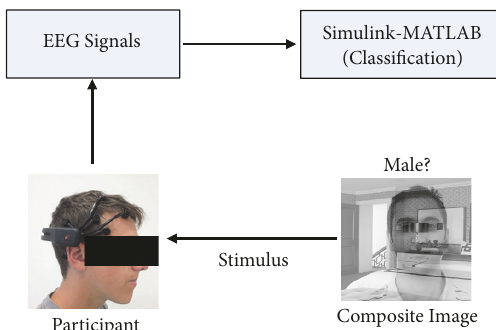
Figure 1: A schematic of the EEG-based BCI system for decoding brainwaves during sustained attention